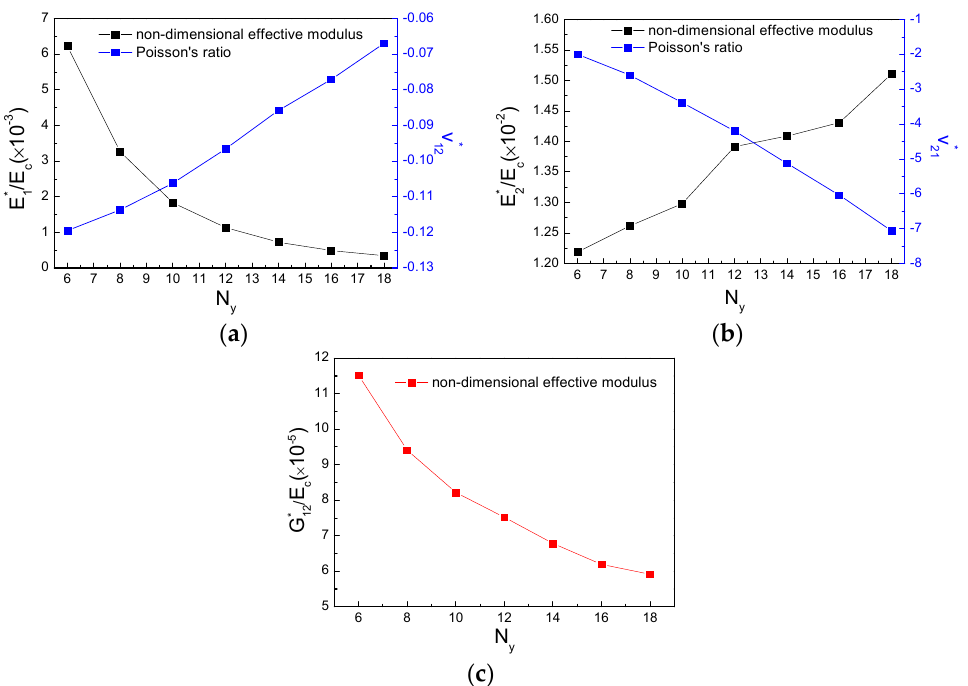
Figure 10. Variation of subordinate cell amount N y verse: ( a ) E ∗ and Poisson’s ratio ν ∗